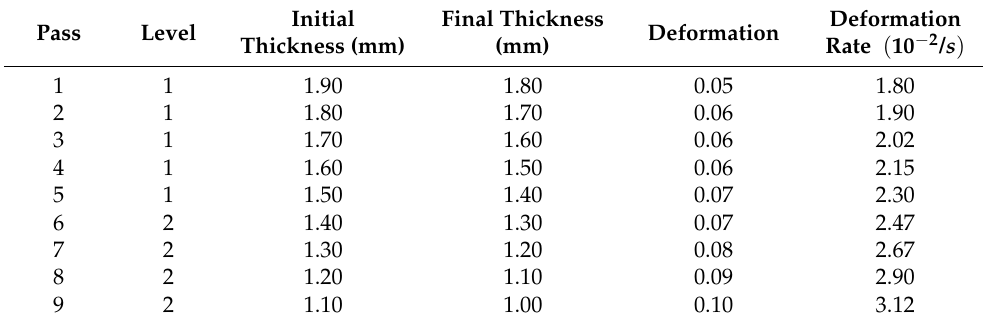
Table 2. Deformation rate per pass and by level in the studied